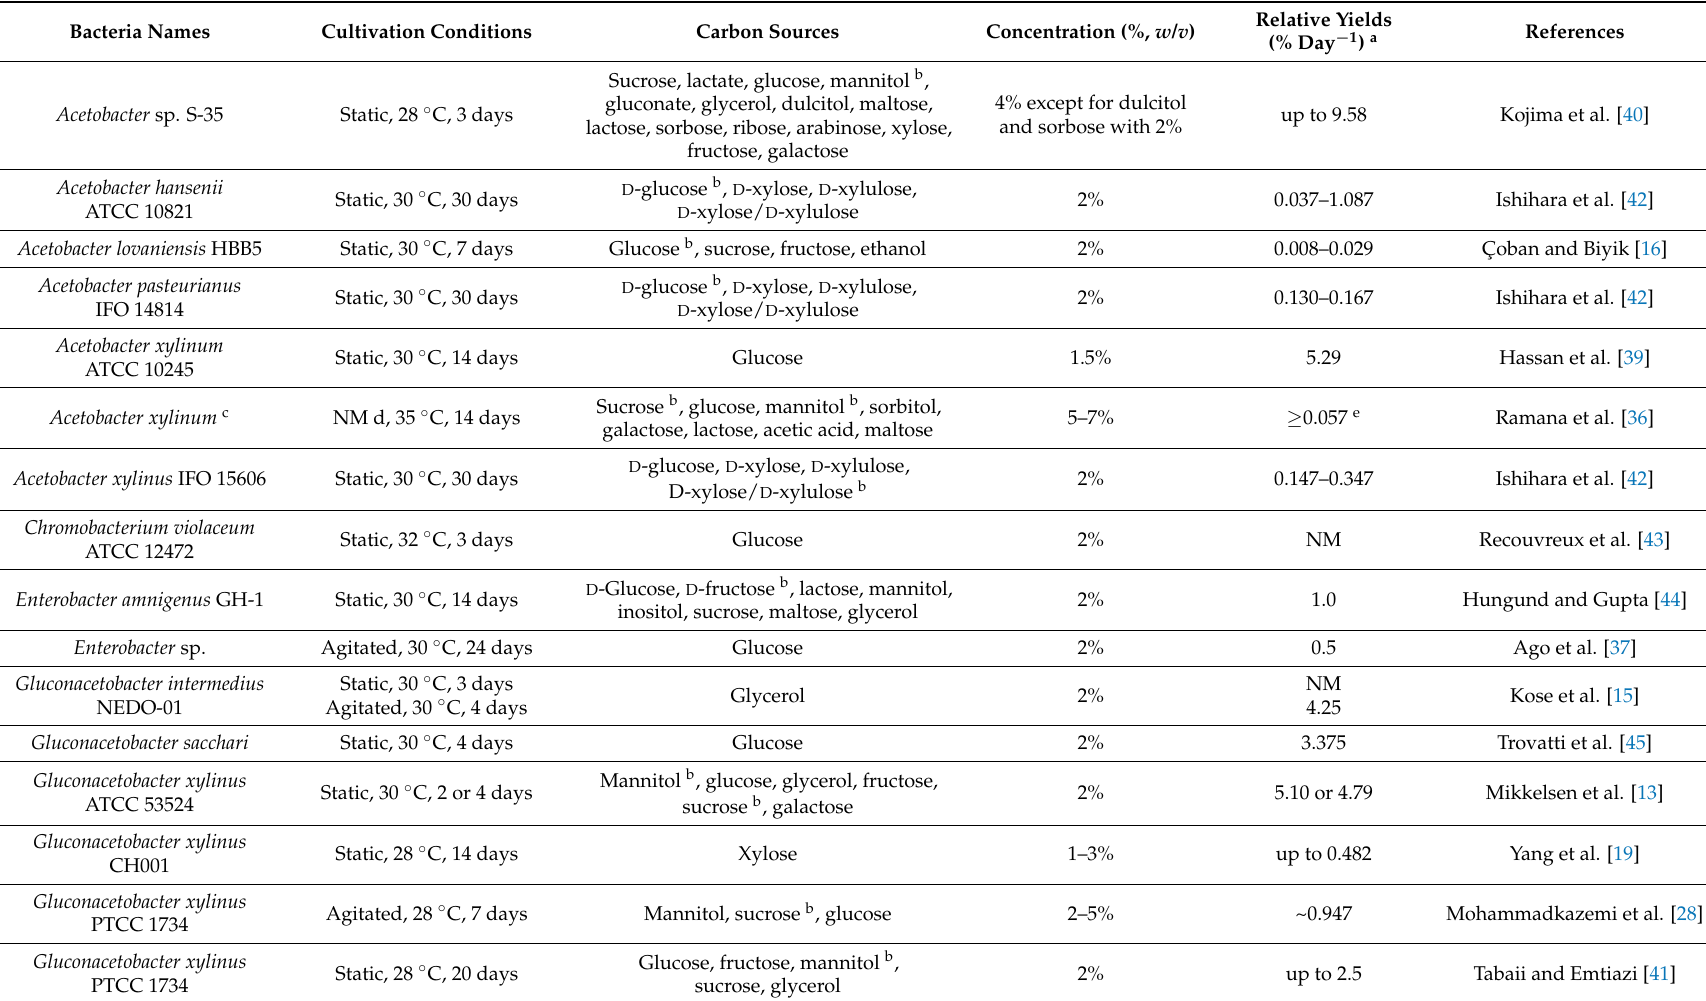
Table 1. The carbon sources used for bacterial cellulose (BC) production and BC productivity in representative bacterial